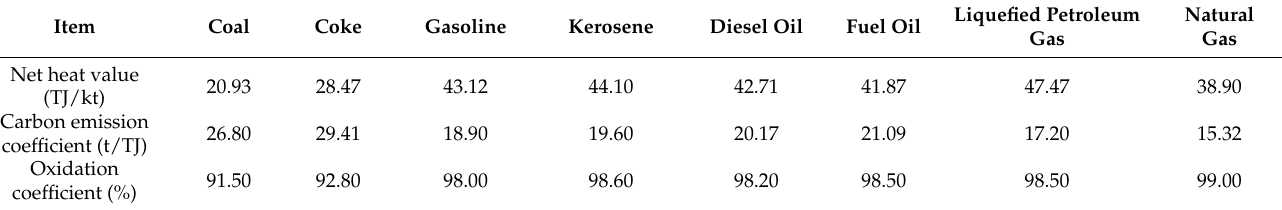
Table 2. Net heat value, carbon emission coefficient, and oxidation coefficient of the eight energy